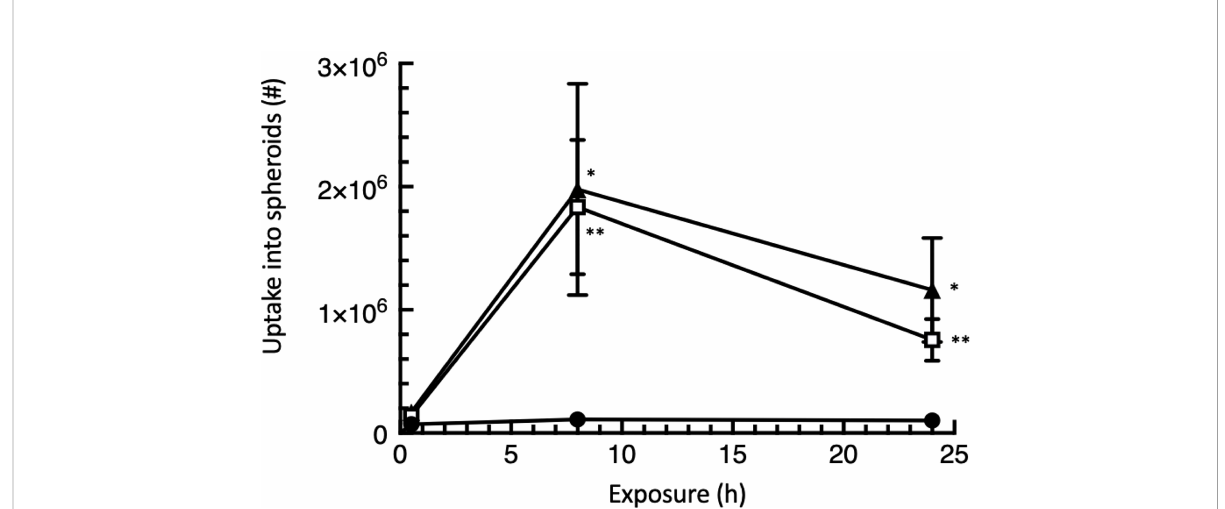
FIGURE 5 EGF decoration of l phage substantially enhances penetration of into HT-29 colorectal cancer spheroids. HT-29 spheroids were exposed to 10 8 phages for the times shown and the total that had in fi ltrated into the spheroids then recovered by fully dissociating the spheroids and subjecting the cells to complete lysis. Each of the data points has been adjusted to allow for the loss of inherent phage infectivity due to the treatment duration. The data mean values ± SEM, calculated from 3 independent experiments each with 3 replicates. An uptake of 2 x 10 6 phage corresponds to 2% of input. The symbols represent l, WT l ; □ , EGF Lo l ; s, EGF Hi l . Signi fi cant differences from WT: * P<0.05; **